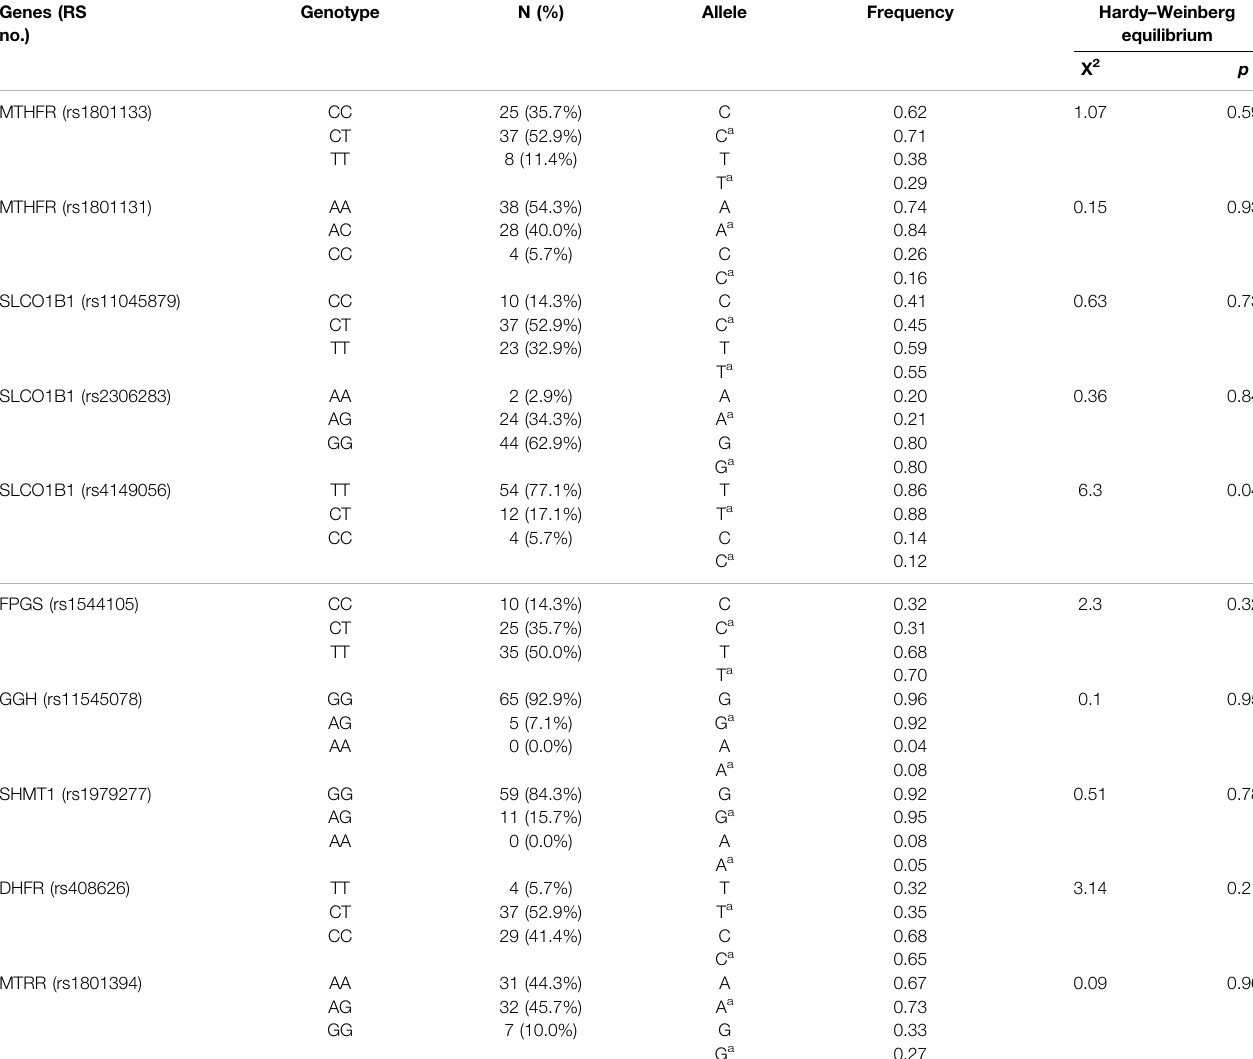
TABLE 2 | Basic information and distribution of genotypes. Genes (RS